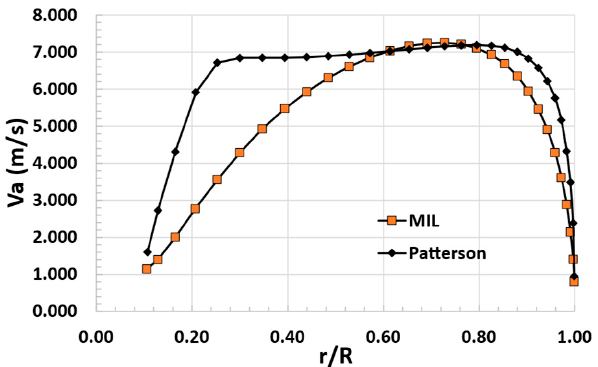
Figure 10. Induced axial speed Va (m/s) for DEP propeller designed following Patterson approach and the equivalent one designed following the MIL approach.